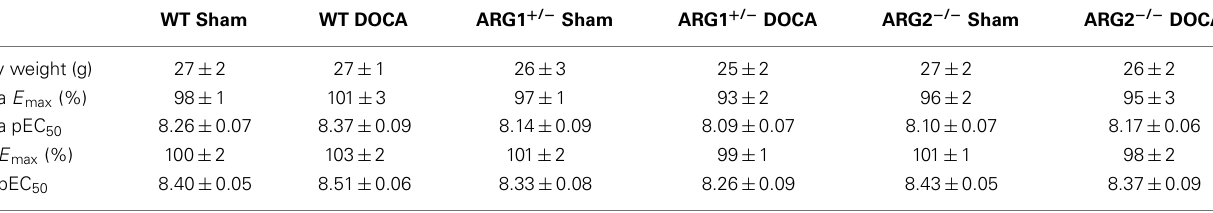
Table 1 | Body weight (g) did not differ amongWT,ARG1 + / − , andARG2 − / − mice in uninephrectomized (WT Sham) or DOCA-salt treated mice.